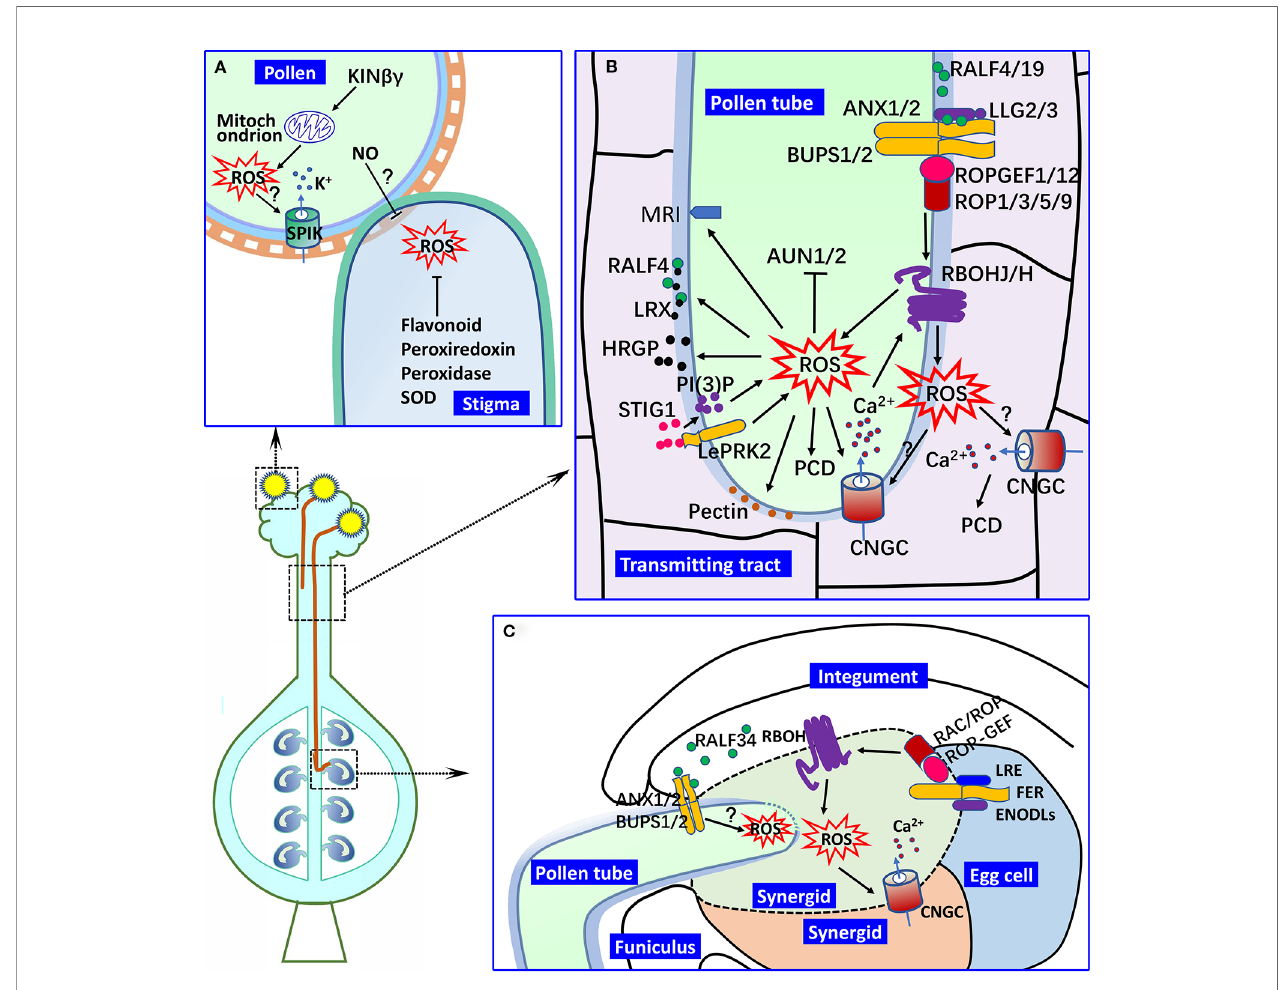
signaling, by which ROS signaling mediates K + transport and pollen hydration on the stigma. ROS accumulation is found in receptive stigma, which is important for pollen attachment, but its decrease is required for the germination of compatible pollen. The ROS levels of the stigma are controlled by various oxidoreductase and fl avonoids and could also be regulated by NO from the pollen. (B) Pollen tube growth in the pistil. NAD(P)H oxidase RBOHH/J-mediated apoplastic ROS production in the growing tip of the pollen tube is important for pollen tube integrity and growth in the pistil by regulating the activities of calcium channels (such as the CNGCs), the secretion of HRGPs (such as LRXs), and the metabolism of wall materials (such as pectin and callose). A type one protein phosphatase (AUN1/2) and plasma membrane-localized receptor-like cytoplasmic kinase MRI also function downstream of ROS signaling in pollen tube growth. The RALF-LLG-BUPS-ANX receptor – ligand interaction is involved in the active regulation of RBOHs and ROS generation, which is mediated by ROPGEFs and ROPs. Pistil-derived STIG1 induces the ROS production of the growing pollen tube in the transmitting tract mediated by LePRK2 and PI(3)P. Apoplastic ROS of the pollen tube might induce PCD of the transmitting tract by mediating CNGC activity and Ca 2+ signaling. (C) Pollen tube reception in the female gametophyte. Pollen tube rupture in the synergid is controlled by ROS from RBOHs in the female gametophyte. LRE and ENODLs serve as the co-receptors of FER to regulate the activity of RBOHs and ROS generation in the synergid, and RAC/ROP might mediate this process. RALF34 primarily derived from the inner integument controls the pollen tube rupture in degenerated synergid by binding to the BUPS/ANX receptor complex in the pollen tube, during which ROS might act downstream of the BUPS/ANX receptor complex. (? indicates the putative